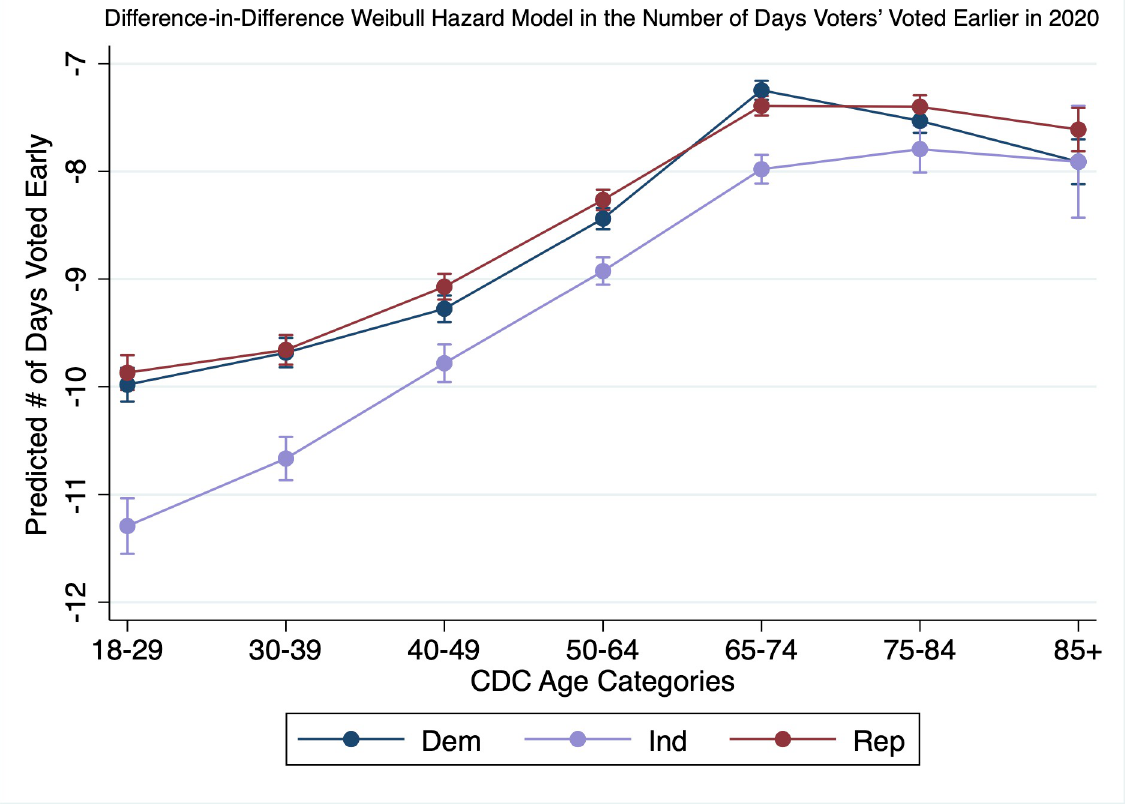
Fig 7. Difference-in-differences Weibull hazard model in the number of days voters’ voted earlier in 2020.